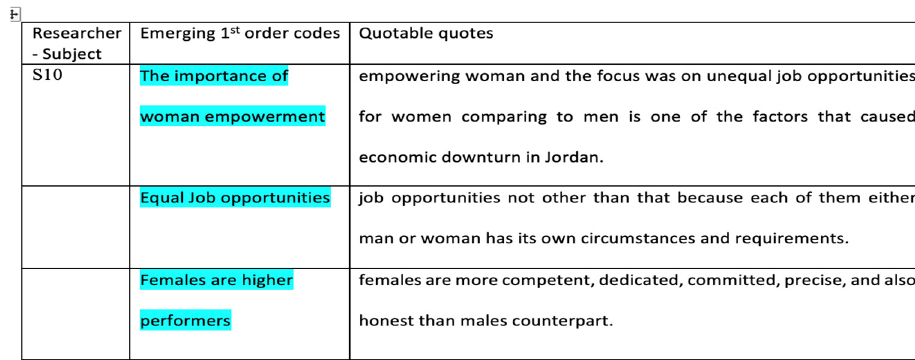
Figure 2. Sample axial coding.